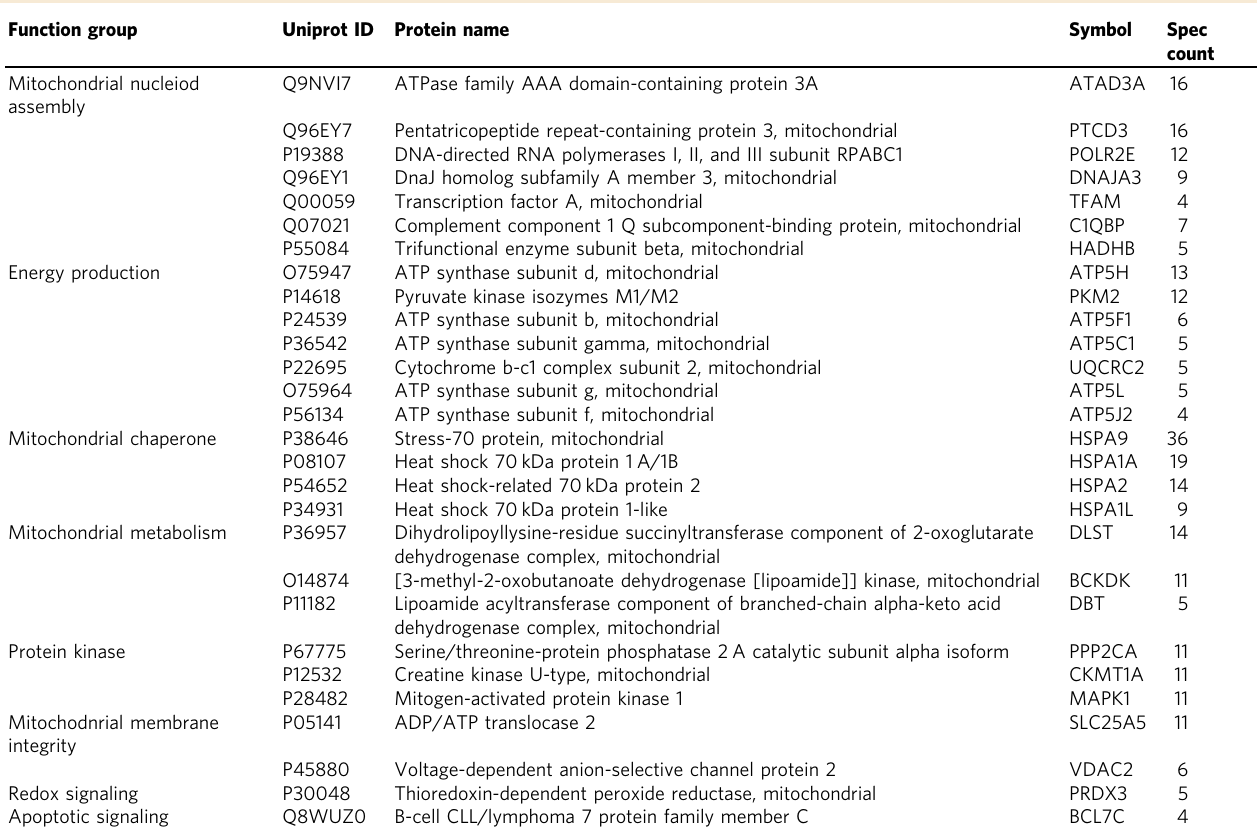
Table 1 A list of mitochondrial candidates that bind to Drp1 in neuronal cells derived from HD patient-iPS cells and not in cells from normal subjects Function